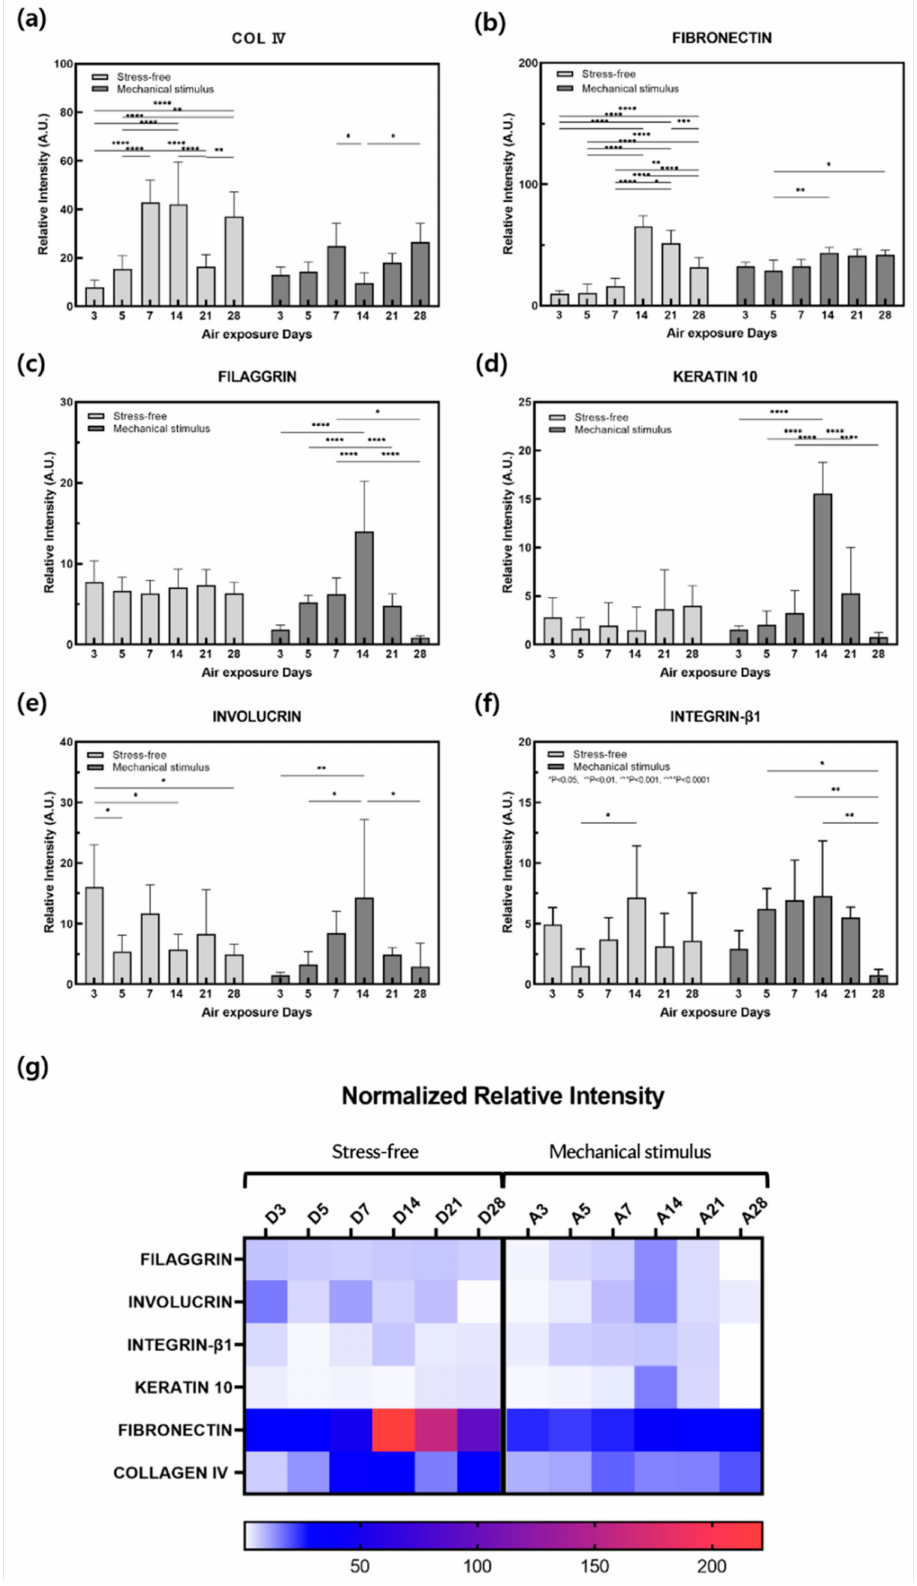
Figure 5. Quantitative analysis of IHC stained images of the ( a ) collagen IV, ( b ) fibronectin, ( c ) filaggrin, ( d ) keratin10, ( e ) involucrin, ( f ) integrin- β for the samples without and with compressive stimulation for various air exposure days. ( g ) Normalized relative intensity of ( a – f ). ( n = 5; *, p < 0.05; **, p < 0.01; ***, p < 0.001; ****, p <